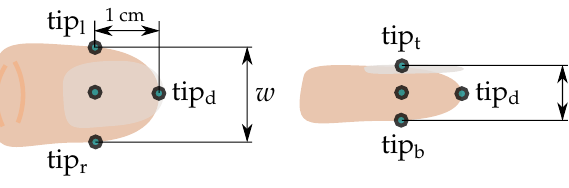
Figure 10. Fingertip in top view ( left ) and side view ( right ). Marked are the points of contact on the left and right (tip l ,tip r ), on the top and bottom (tip t ,tip b ) and at the distal tip (tip d ) of the finger. The parameter w is the width, t the thickness of the